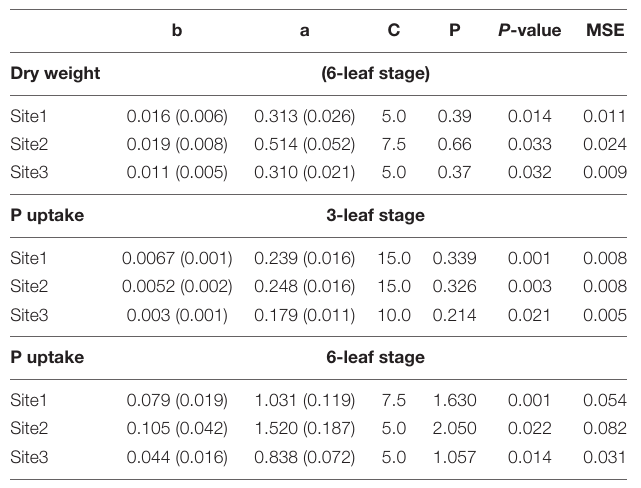
TABLE 5 | Parameters of the linear-plus-plateau response curves (Y = bx + a) to P fertilization of corn dry weight at the 6-leaf stage, corn P uptake at the 3- and 6-leaf stages in 2018.